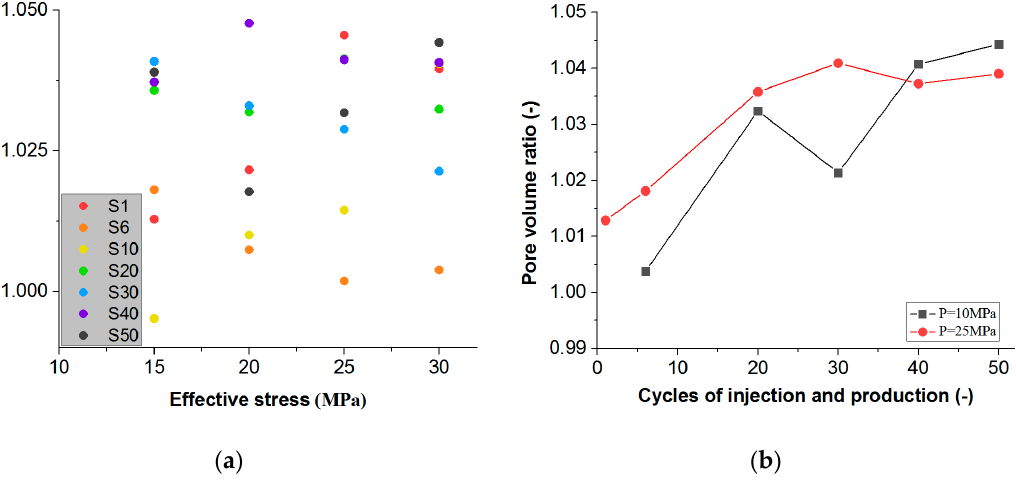
Figure 13. Variation in volume ratio of total pores with effective stress ( a ) and cycles of injection– production ( b ).